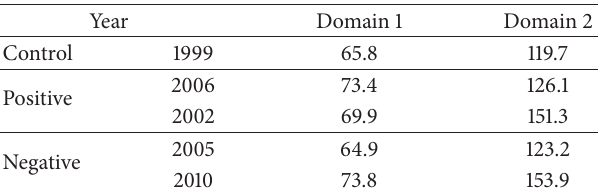
Table 3: RMSE (mm) for each extreme year and for both domains. 2010 saw a large increase in